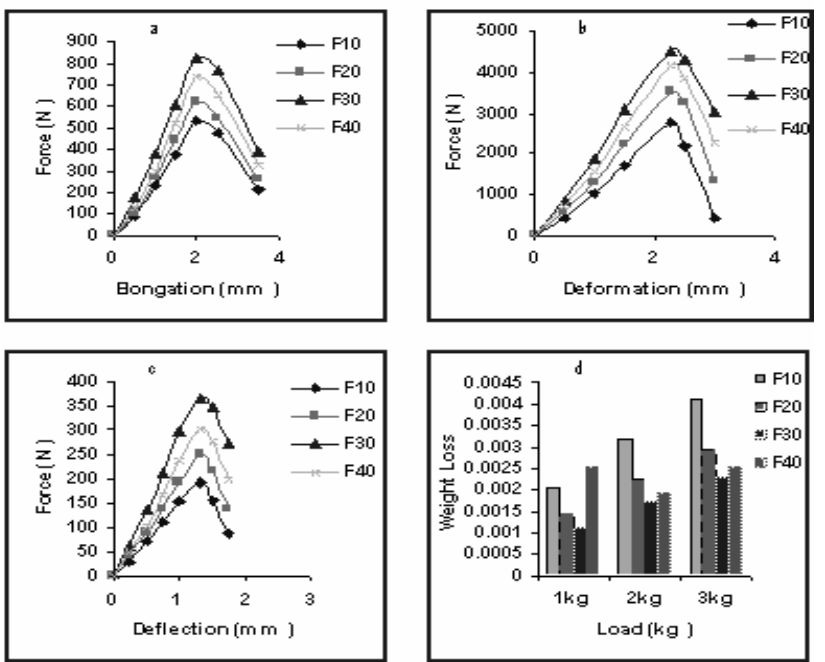
Figure 2. Load elongation/deformation/deflection & wear resistance curve of fiber reinforced composites (a, b, c, d)